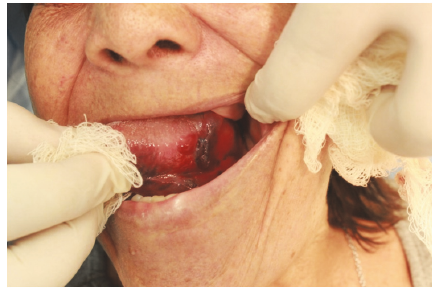
Figure 7: Postoperative week 1.